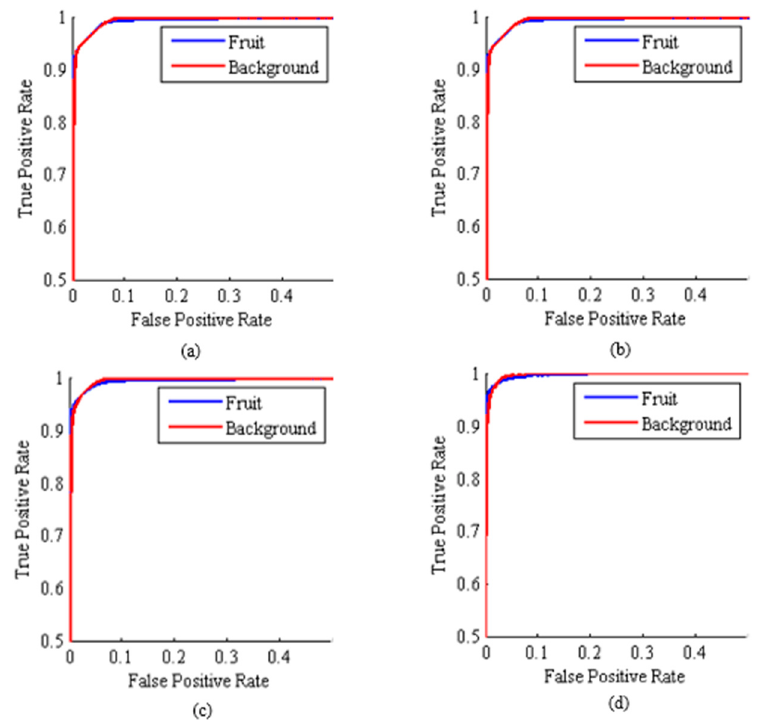
Figure 4. Receiver operating characteristic (ROC) curves obtained by the classifiers for the 500 iterations on the test data. ( a ) Hybrid ANN ‐ BA; ( b ) Hybrid ANN ‐ BBO; ( c ) Hybrid ANN ‐ FA; ( d ) Voting method.